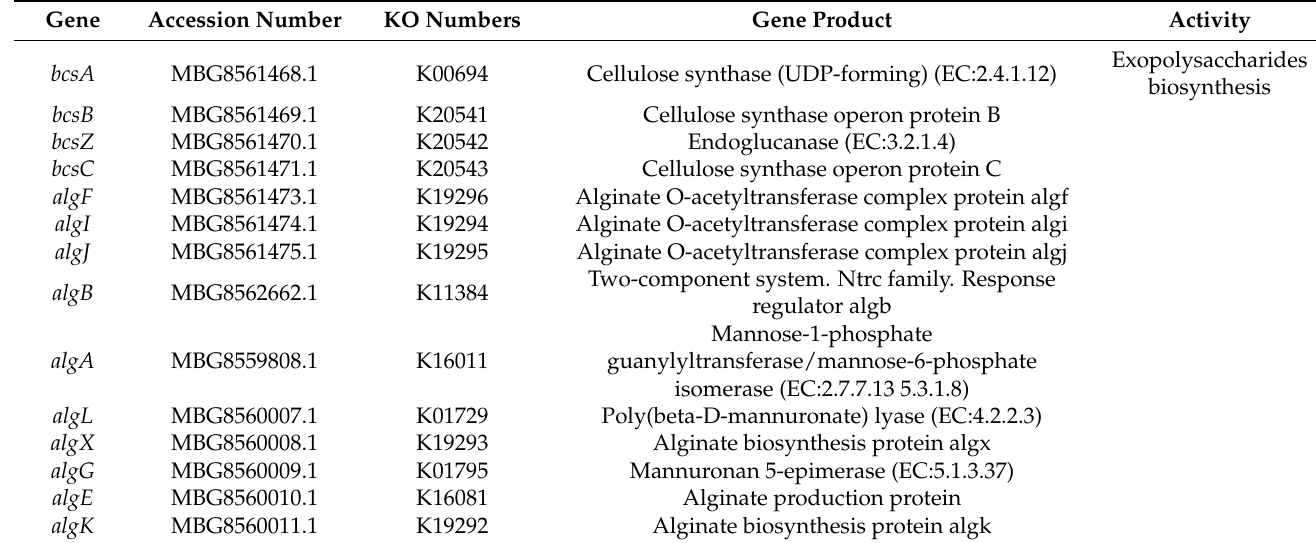
Table 6. Genes involved in exopolysaccharides